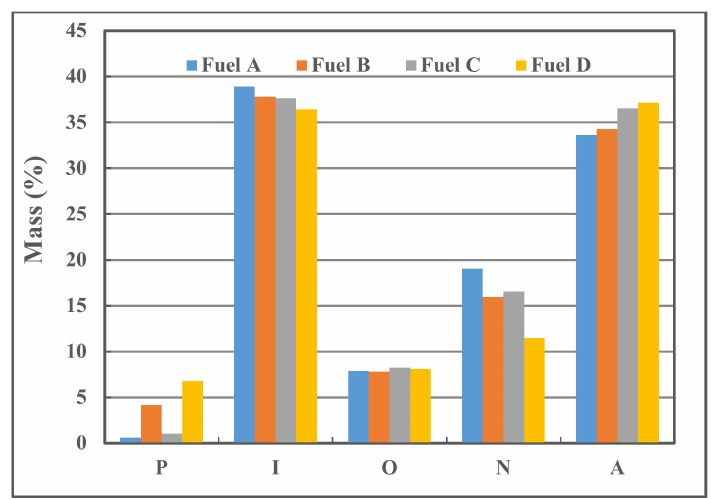
Figure 3. PIONA (paraffins, iso-paraffins, olefins, naphthenes, and aromatics) analysis results.